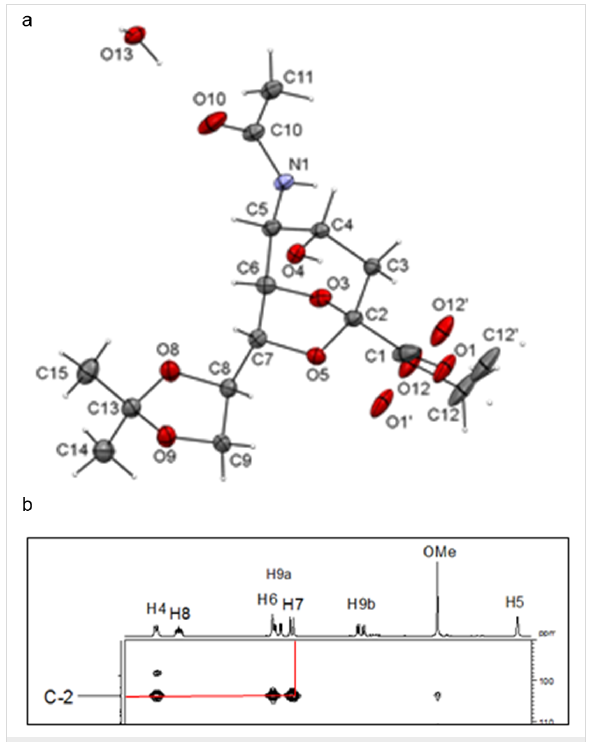
Figure 2: a) ORTEP diagram of compound 4 . Thermal ellipsoids indi- cate 50% probability. b) HMBC spectrum of 6